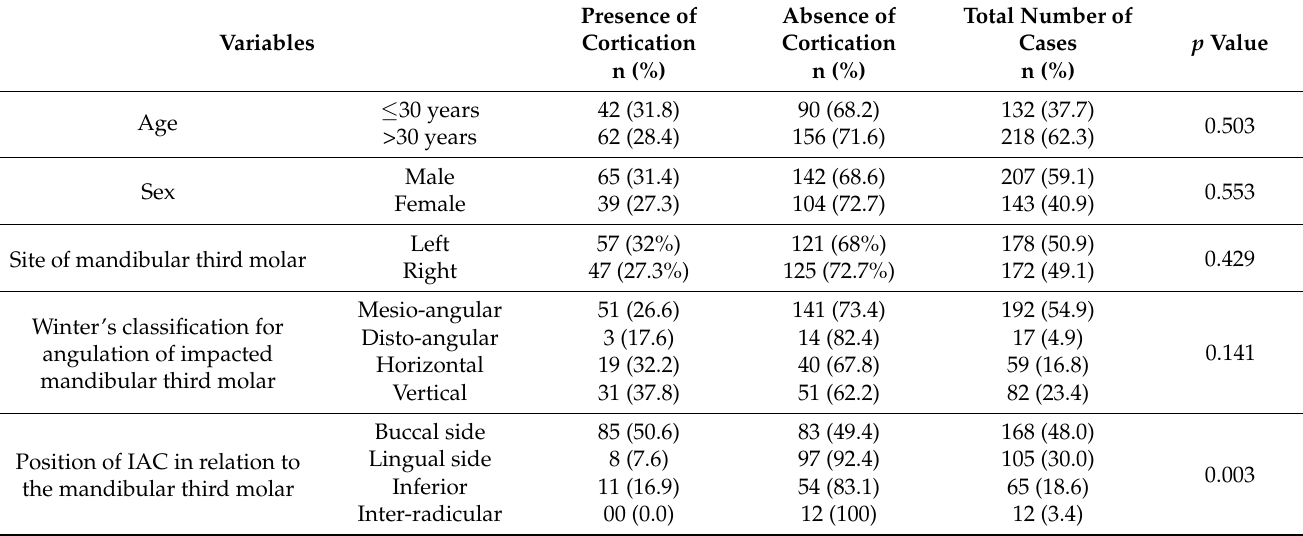
Table 1. Comparison between prevalence of cortication and various study parameters.